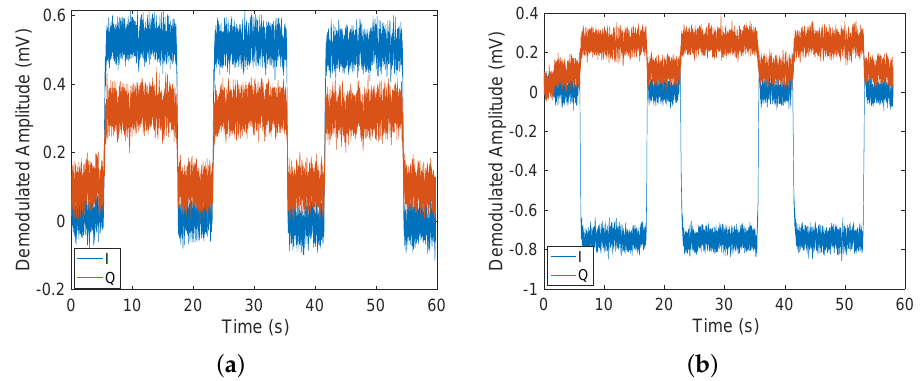
Figure 5. Time traces of the lock-in outputs when detecting conductive objects with the fluxgate magnetometer and the active detection setup for ( a ) the solid aluminium cylinder and ( b ) the solid steel cylinder. The conductive object was placed 22.4 cm away from the excitation coil. For these measurements, the primary magnetic field was 1.09 µ T at the magnetometer position and oscillated at a frequency of 500 Hz.